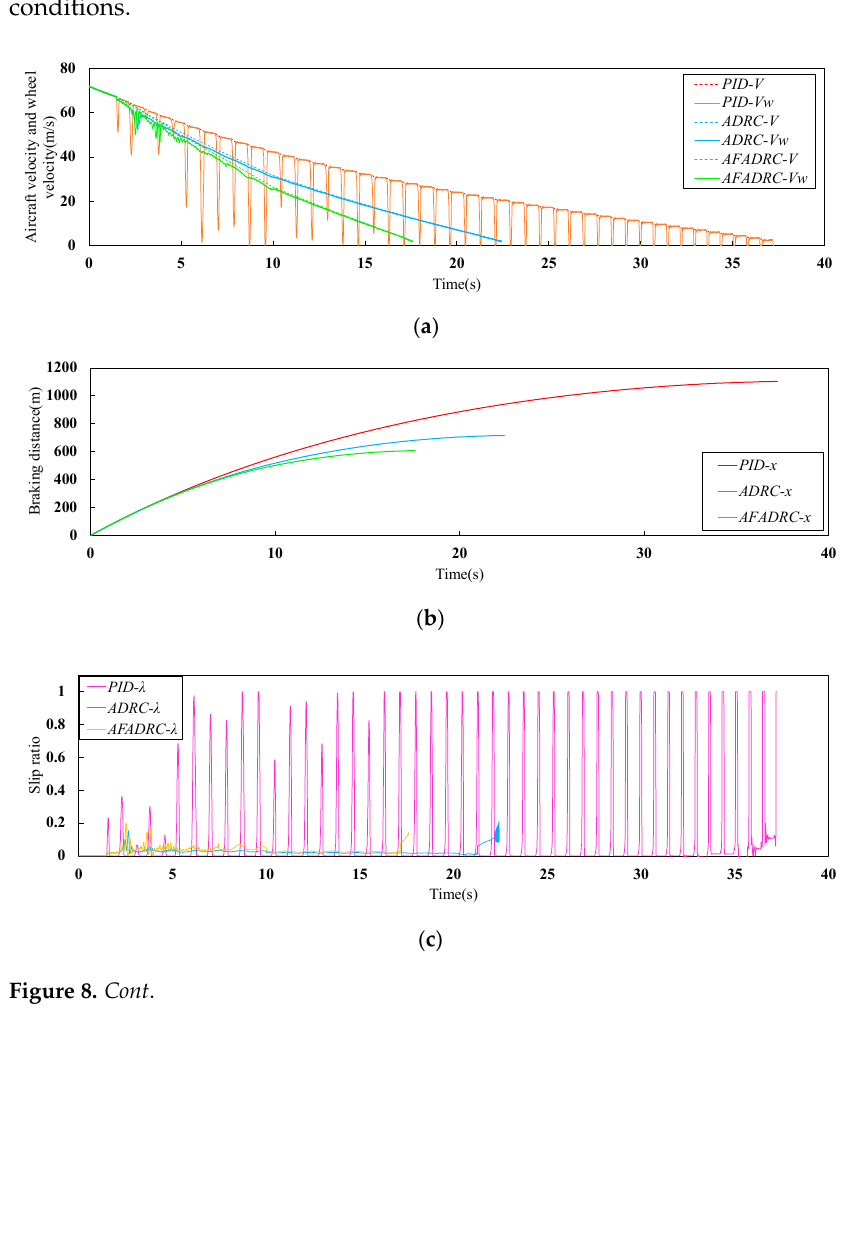
( e ) ( f ) Figure 8. Case 2 simulation results: ( a ) aircraft velocity and wheel velocity; ( b ) breaking distance; ( c ) slip ratio; ( d ) AESO parameters; ( e ) control input; ( f ) extended state.